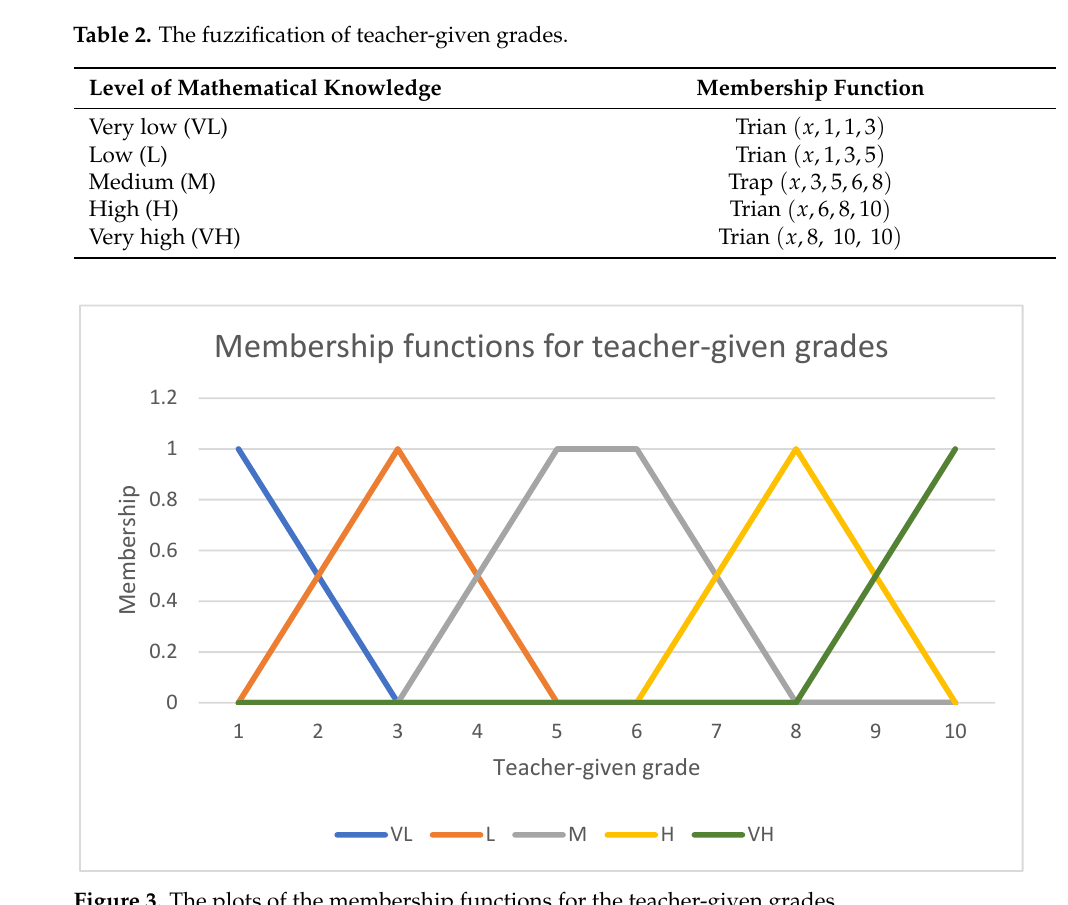
Figure 3. The plots of the membership functions for the teacher-given grades.